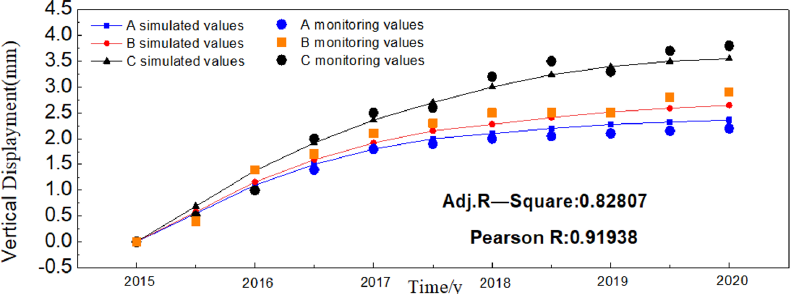
Figure 7. Correlation curve between the estimated settlement and the monitored settlement of the monitoring points.